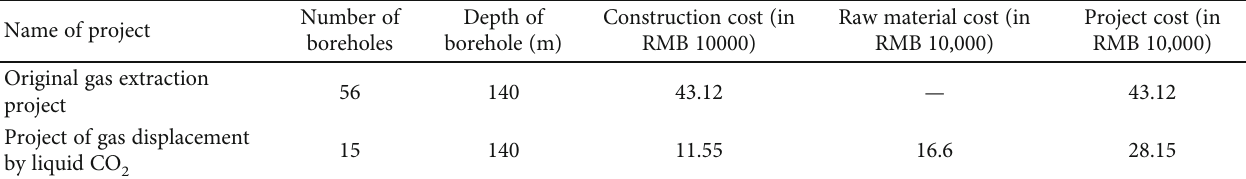
Table 5: Comparison of economic bene fi